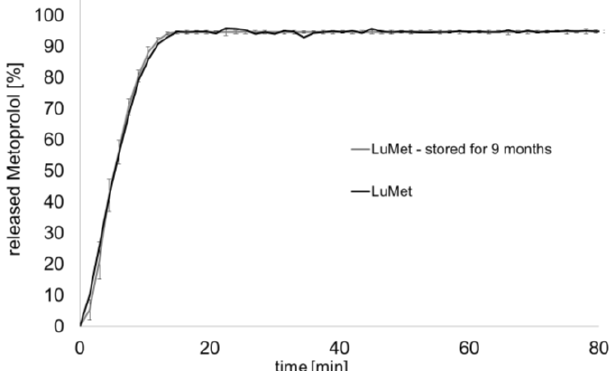
Figure 9. Dissolution of cut slices from metoprolol tartrate extrudates by the SDP (d = 3 mm) before and after storing nine months at accelerated conditions, 900 mL water, 37 °C, basket apparatus, 50 rpm, mean ± s, n =